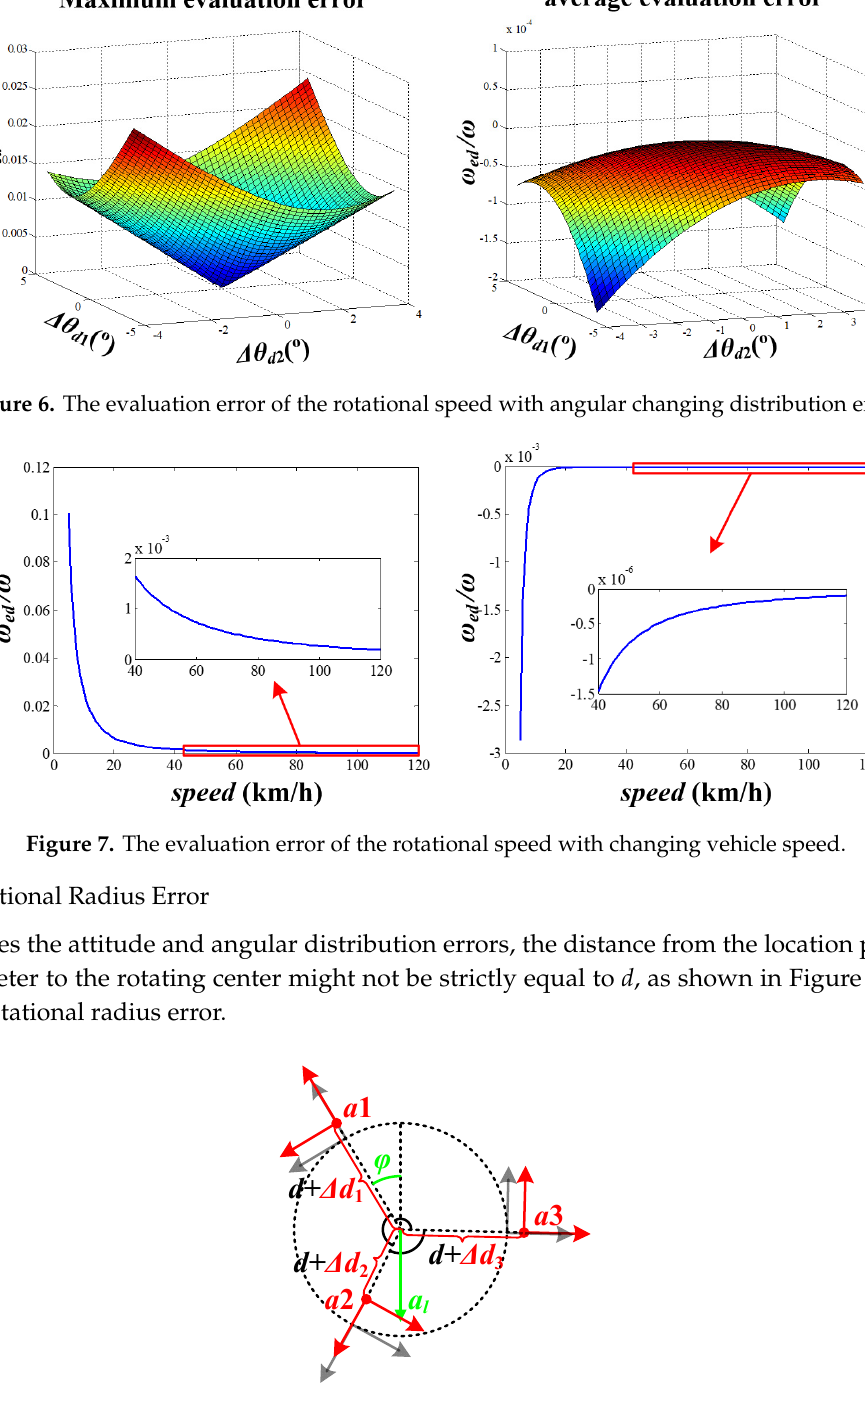
Figure 8. Description of the rotational radius error.